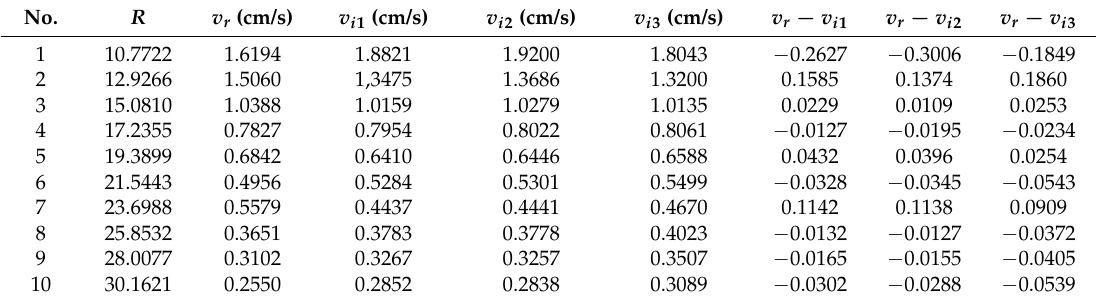
Table 3. Survey of recorded and calculated rock mass oscillation velocities for models 1, 2 and 3.